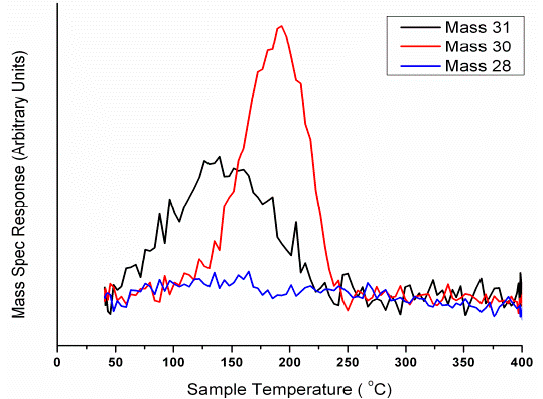
Figure 2. TPD profile for MeOH adsorbed onto the surface of Fe 2 (MoO 4 ) 3 . Method as in Figure 1.